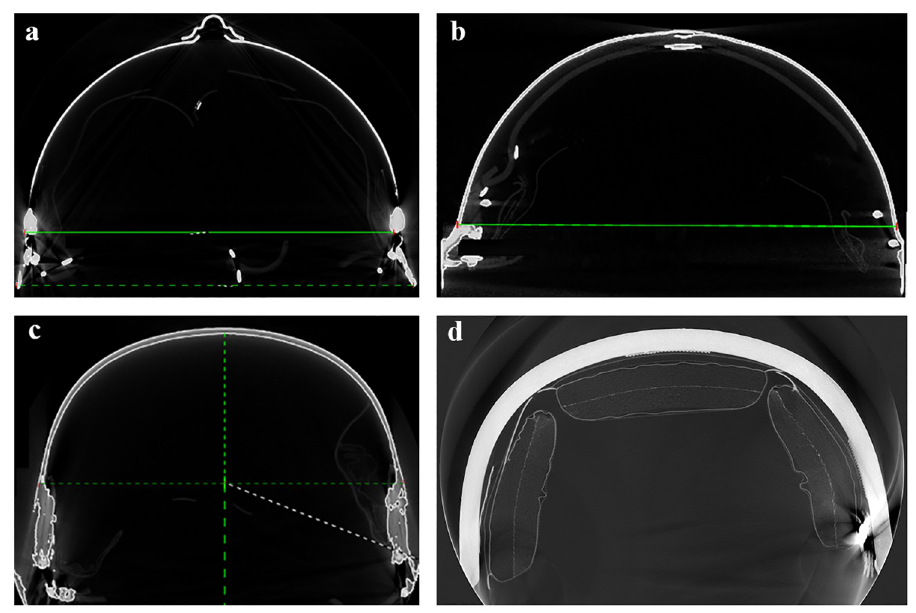
Fig 1. Coronal CT sections of tested helmets. (a) Adrian helmet, (b) Brodie helmet, (c) Stahlhelm, (d) Advanced Combat Helmet (ACH). The Adrian helmet (a) is the thinnest steel followed by the Brodie (b) and the Stahlhelm (c). The ACH (d) is made with a fiber composite material.